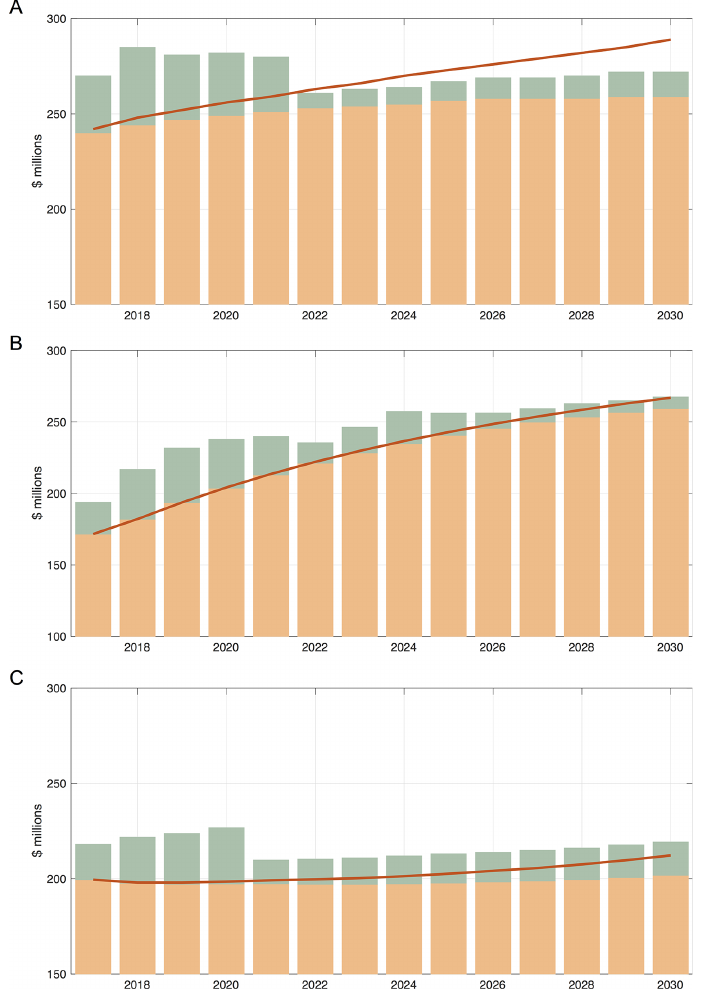
Fig 3. Costs of VMMC and ART in the scenario in which the program targets for 2021 are achieved in a ’status quo’ setting (without Fast Track), compared to our counterfactual scenario of no VMMCs ever, from (A) the Goals model, (B) the ICL model, and (C) the EMOD model. Shown are the cost of VMMC if the program targets are met and maintained (green bars), the cost of ART if the program targets are met and maintained (orange bars), and the cost of ART in the counterfactual scenario with no VMMC ever (red curves). As in previous tables and Figs, Goals (A) and EMOD (C) consider all age groups and ICL (B) only ages 15–49.